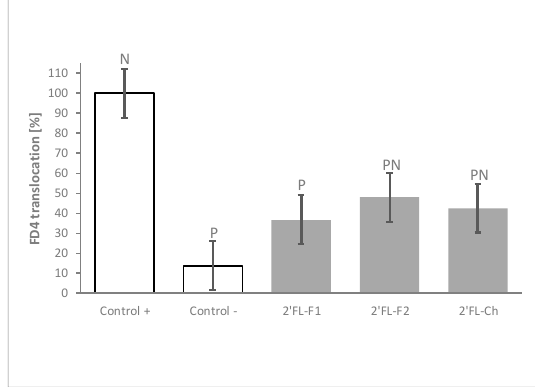
Figure 4. The process of 2 ′ FL synthesis does not influence its protective effects. FD4 translocation with 2 different bacterial fermentation (2 ′ FL-F1 and 2 ′ FL-F2) and 1 chemical (2 ′ FL-Ch) production batches of 2 ′ FL at 30 mg/mL. Controls were non-HMO treated cells and cytokine unchallenged cells (Control –) and non-HMO treated cells, but cytokine challenged (Control +). Means ± 0.5 x LSD5% are presented, so that two conditions are significantly different if their error bars do not overlap. Significant differences vs. controls are highlighted (P = different from Control +, N = different from Control − ). 2 ′ FL: 2 ′ Fucosyllactose; FD4: 4 KDa FITC-Dextran; LSD 5% : Fisher’s least significant difference with α = 5%.